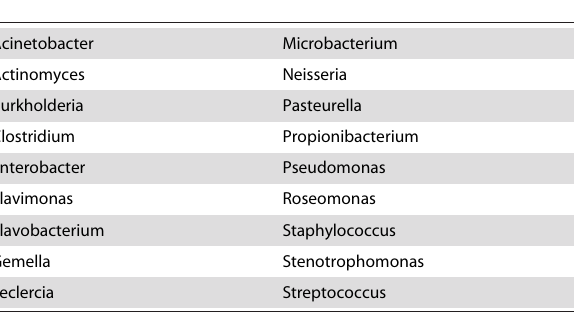
Table S1 Raw sequence counts of bacterial genera